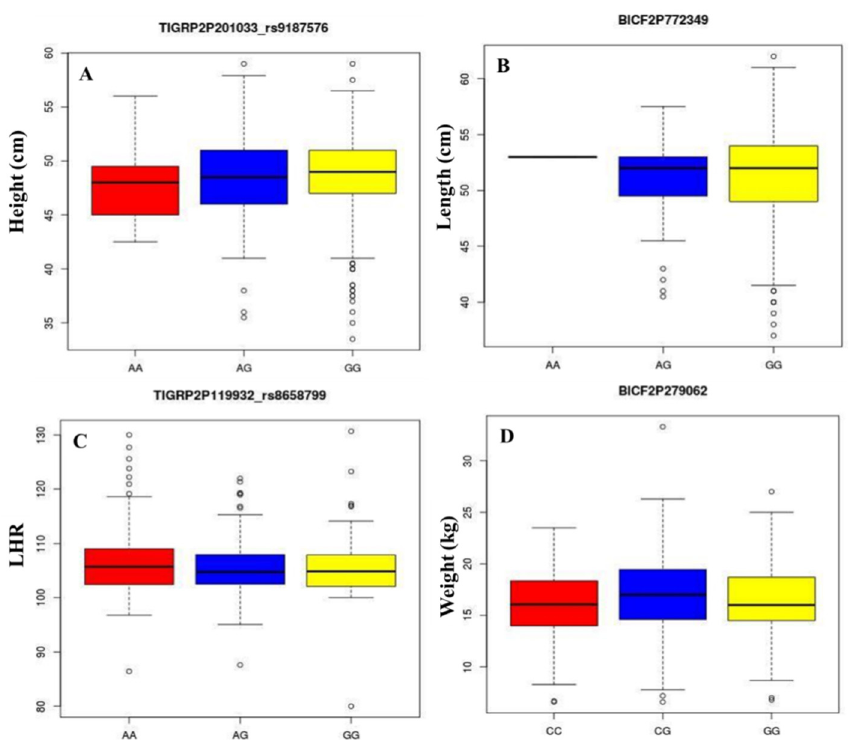
Figure 7. Genotype-phenotype correlation. The box plots show the distribution of phenotypes among the different genotypes of top variants associated to height ( A ), length ( B ), length to height ratio ( C ) and body-weight ( D ). Table 3. Effect of top SNP genotypes on the height, length, LHR and weight trait in Jindo dog.